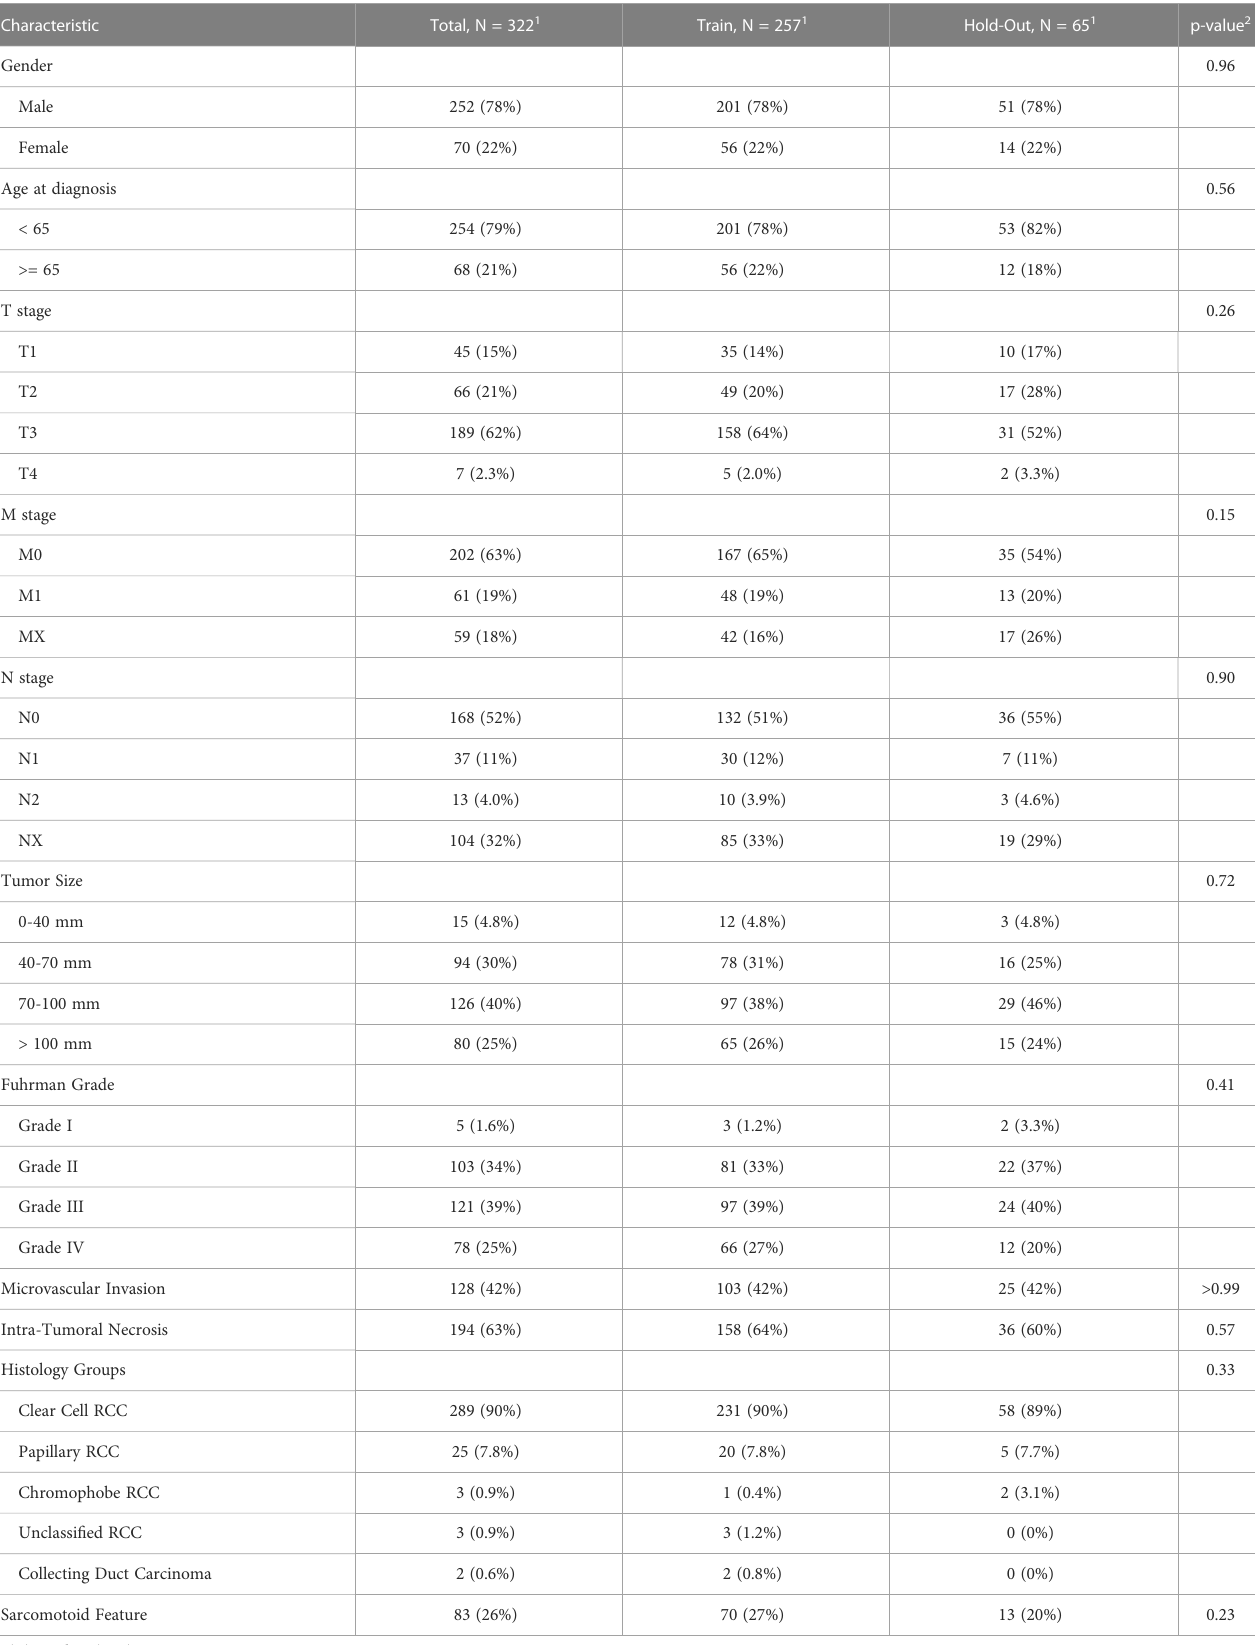
TABLE 1A The clinicopathological characteristics of the RCC patients from this study avaialble at the diagnosis time.